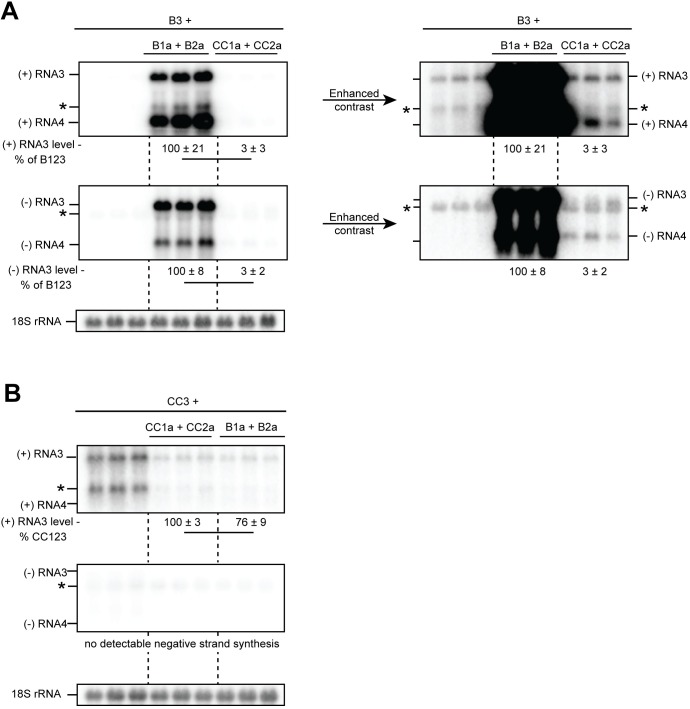
Virus and RNA template specific differences in RNA replication levels in yeast.(A) Total RNA from yeast expressing BMV RNA3 alone, lanes 1–3; BMV RNA3, BMV 1a, and BMV 2a, lanes 3–6; or BMV RNA3, CCMV 1a, and CCMV 2a, lanes 7–9 was probed for positive and negative- strand RNA3 and 4 as indicated by northern blotting. Relative levels of RNA3 are indicated beneath the blots. Blots are shown to the right with strongly enhanced contrast to better visualize replication dependent bands in lanes 7–9. 18S RNA is shown as a loading control. Bands other than (+)RNA3 present in the absence of RNA replication are marked with a an asterisk. (B) As in A, except with a CCMV RNA3 template in place of BMV RNA3. The average and standard deviation of each triplicate shown is presented beneath the blots. A line connecting two numbers indicates a statistically significant difference (p<0.05).